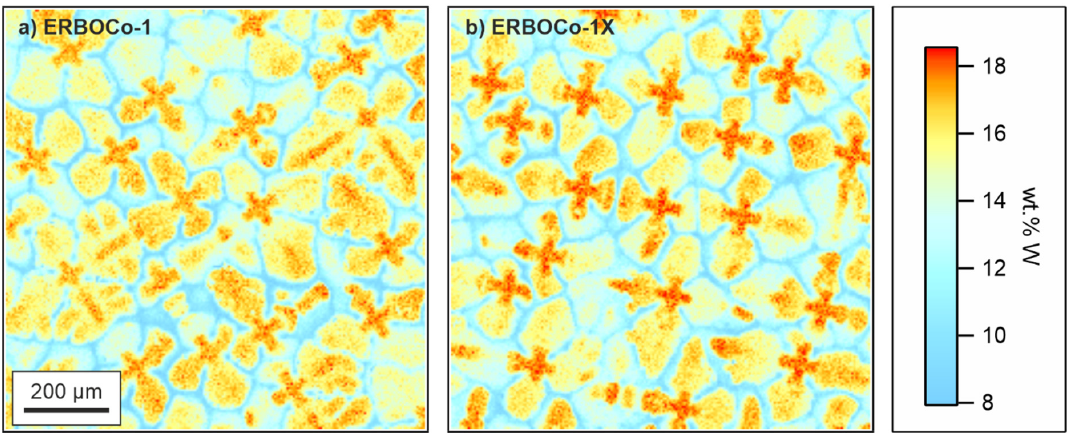
Figure 1. Tungsten segregation in the as-cast state as determined by electron probe microanalysis (EPMA): ( a ) ERBOCo-1 and ( b ) ERBOCo-1X.